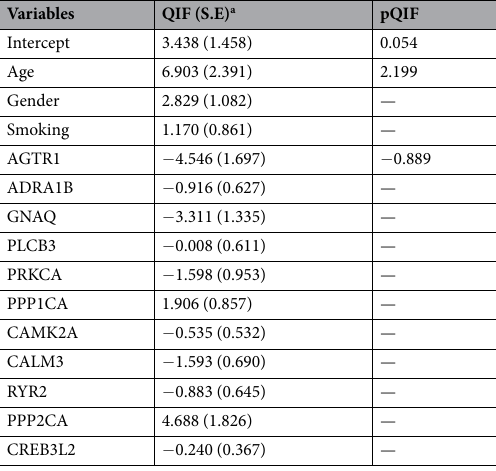
Table 3. Distribution of age, sex, smoking, and hypertension in the GAW18 real dataset at different exam stages. a ± X S ( ) for age in each exam, where X is the average and S is the standard deviation. b Ratios for male: female, smoking: non-smoking, and hypertension: non-hypotension.